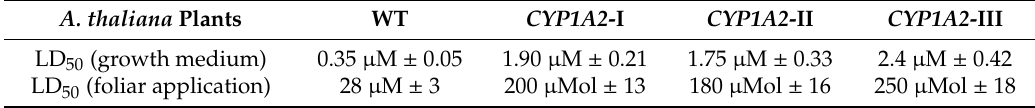
Table 3. LD 50 values of isoproturon in plants.